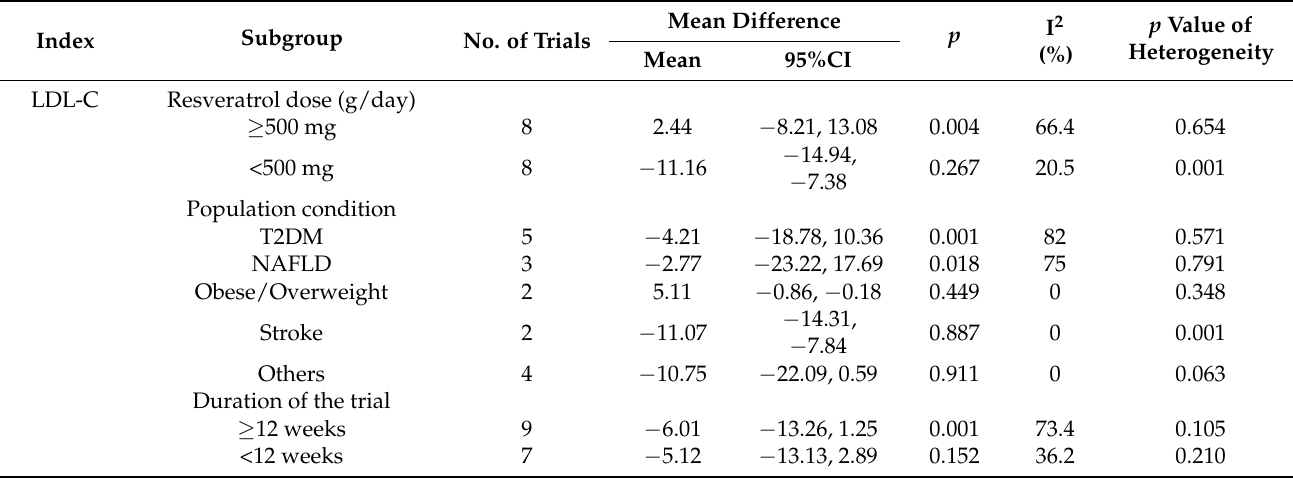
Figure 4. Nonlinear dose–response relations between resveratrol duration (week) and unstandard- ized mean difference (mg/dL) in ( A ) TC, ( B ) HDL-C, ( C ) LDL-C and ( D ) TG. The 95% CI is demon- strated in the shaded regions. TC = Total cholesterol; HDL-C = High-density lipoprotein cholesterol; LDL-C = Low-density lipoprotein cholesterol; TG = Triglyceride. Table 2. The results of subgroup analysis in included